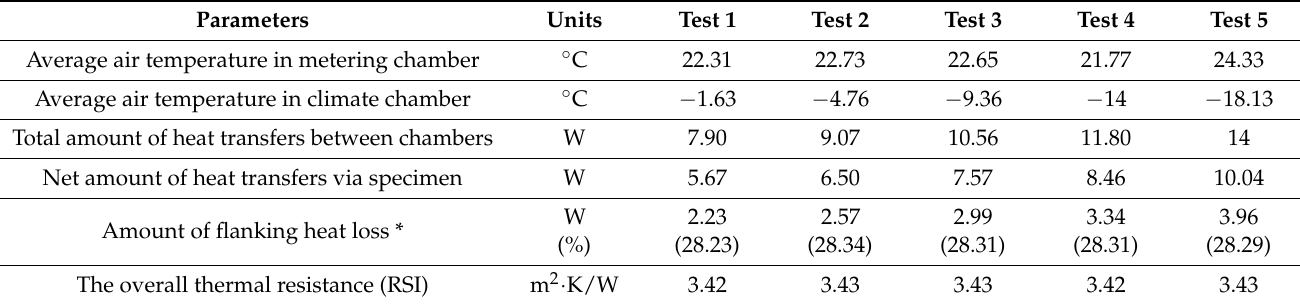
Table 5. Results obtained numerically. Parameters